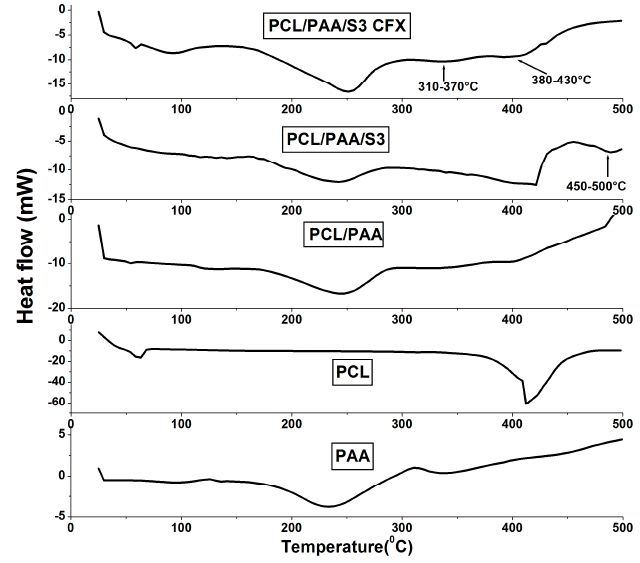
Figure 2. Thermograms of the PCL/PAA blend before and after loading of silica microspheres and CFX with respect to the native polymers, PCL and PAA. CFX with respect to the native polymers, PCL and